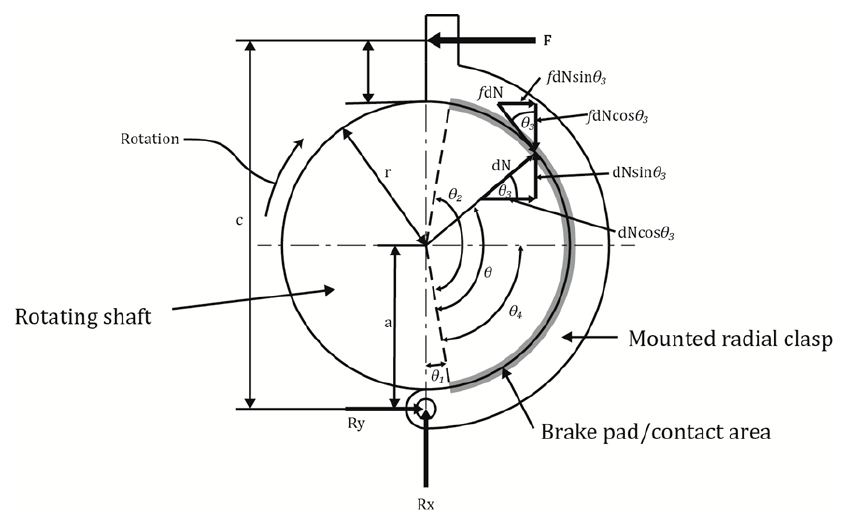
Figure 5. Force and notation of radial clasp arrangement.